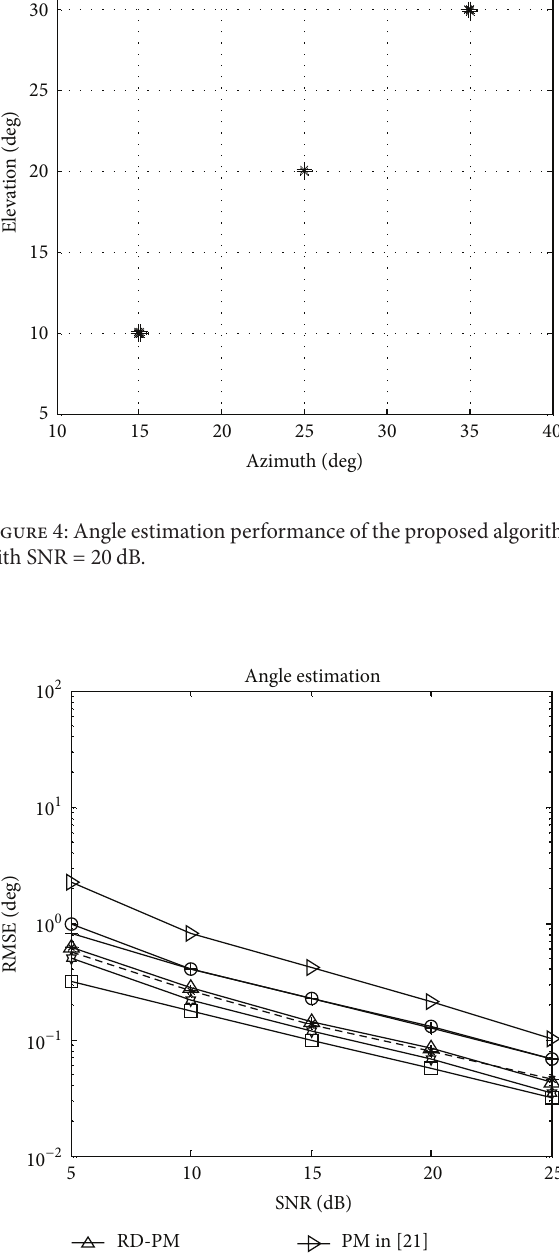
adjacent elements is 𝑑 = 𝜆/2 . Note that 𝑀 and 𝑁 are the numbers of sensors in 𝑥 - axis and 𝑦 -axis, respectively. 𝐽 is the number of snapshots.